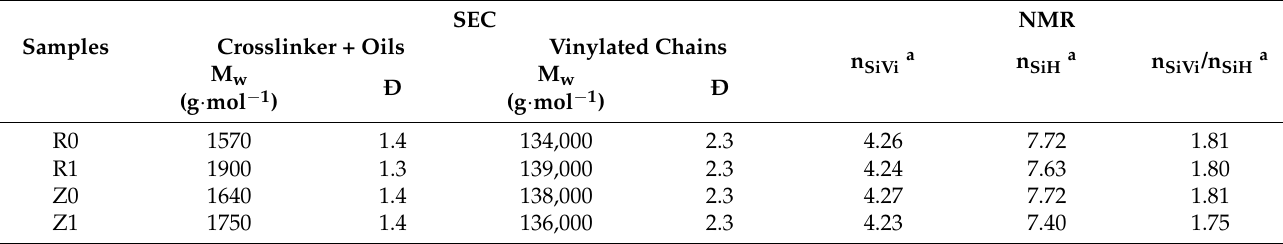
Figure 3. ( a ) Offset SEC traces and peak attribution; ( b ) Offset proton NMR focused on the reactive moieties zone. Table 1. SEC and NMR analyses on LSR formulation without (R) and with (Z) benzophenone that has been irradiated (1) or not (0).